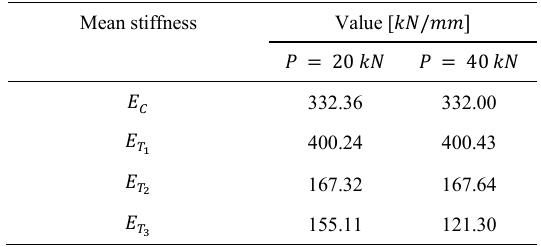
Table 5: Mean stiffness of each segment of the load-displacement curves in Fig.